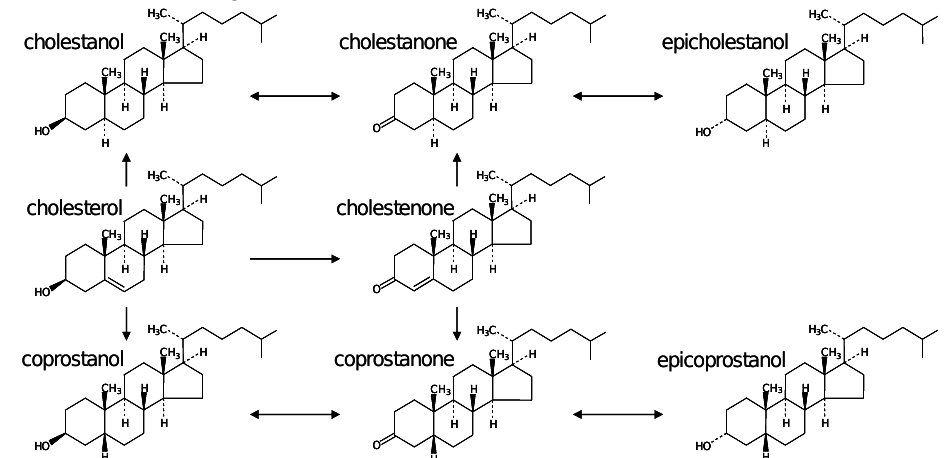
Figure 1 : Structures and environmental transformation pathways of fecal